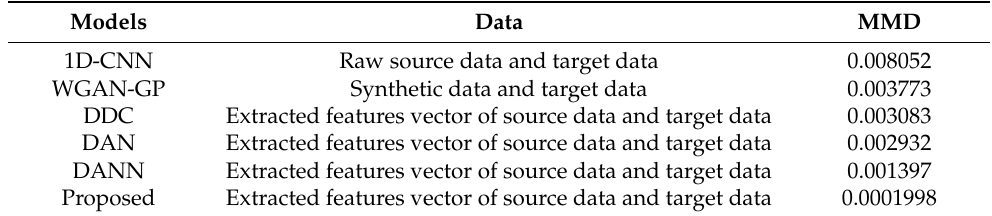
Table 3. Transfer results of six models.